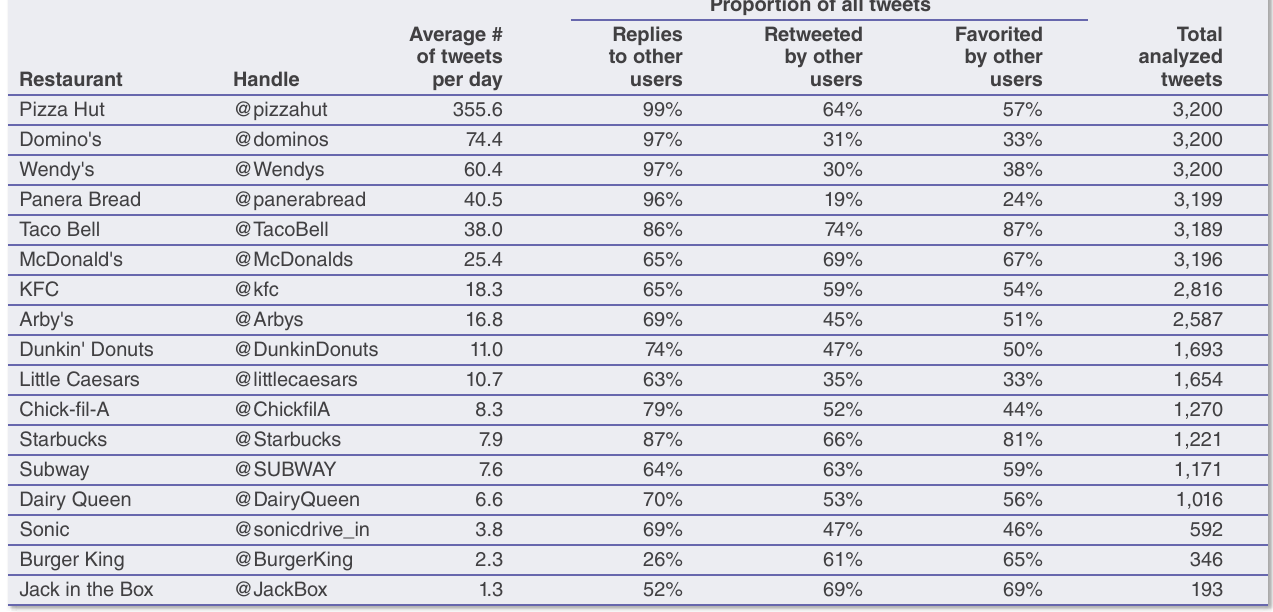
Table 37. Activity on restaurants' main Twitter